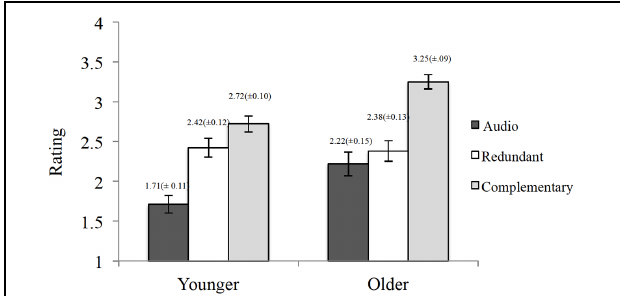
FIGURE 2 | Differences in perceived understanding ratings between presentation conditions for both younger and older adults (bars represent SE).